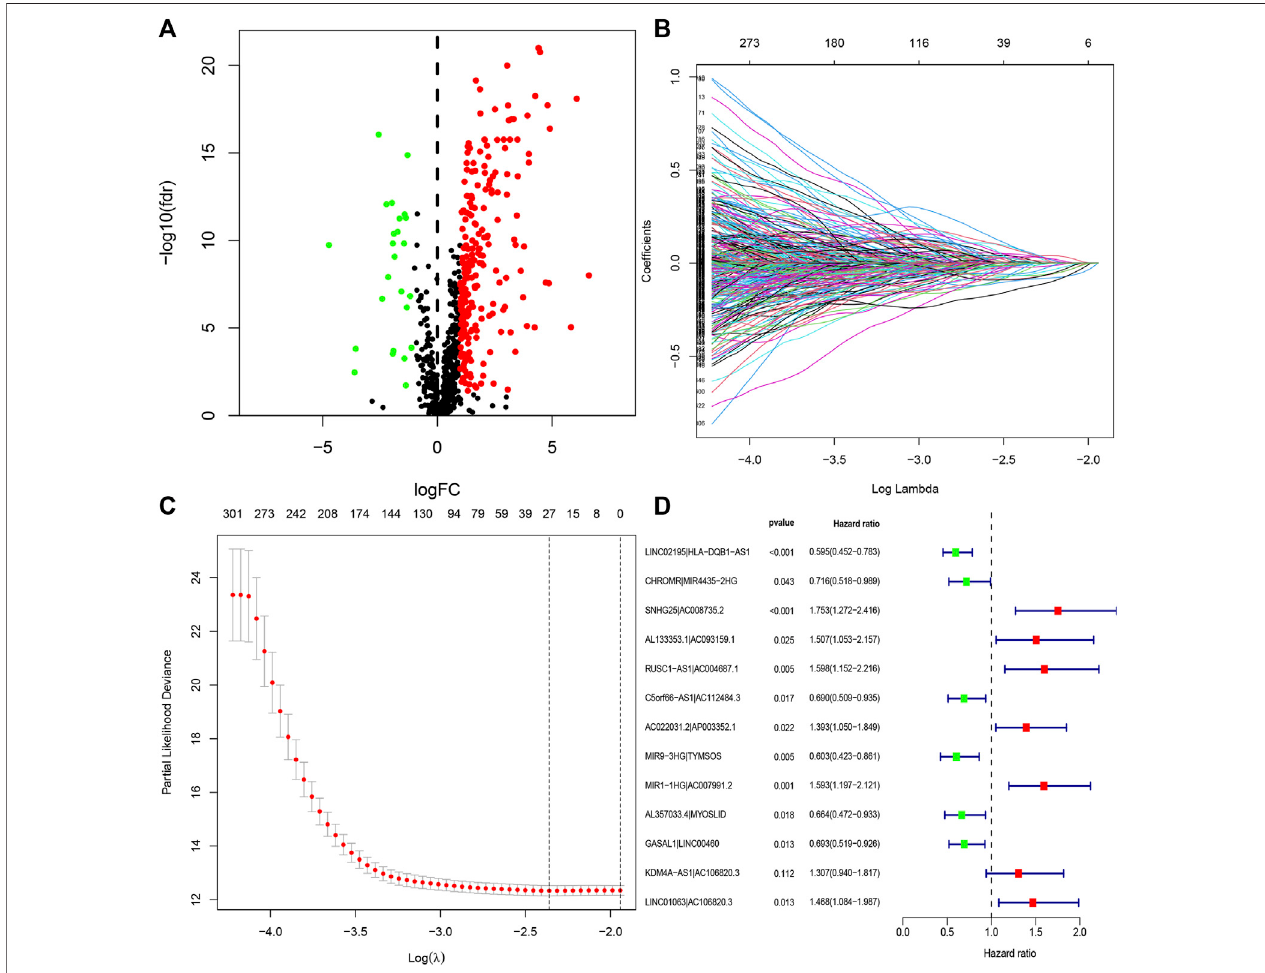
FIGURE 2 | Identi fi cation of DEirlncRNAs and establishment of a risk assessment model. (A) Volcano diagram of DEirlncRNAs. The green, red, and black dots represent the down- and upregulated DEirlncRNAs and lncRNA that did not satisfy the screening criteria, respectively. (B) LASSO coef fi cient pro fi les of the 27 DEirlncRNA pairs. (C) A coef fi cient pro fi le plot was generated against the log sequence. Selection of the optimal parameter in the LASSO model. (D) A forest map displaying 13 DEirlncRNA pairs identi fi ed by the Cox proportional hazards regression model for multivariate analyses using a forward stepwise method.